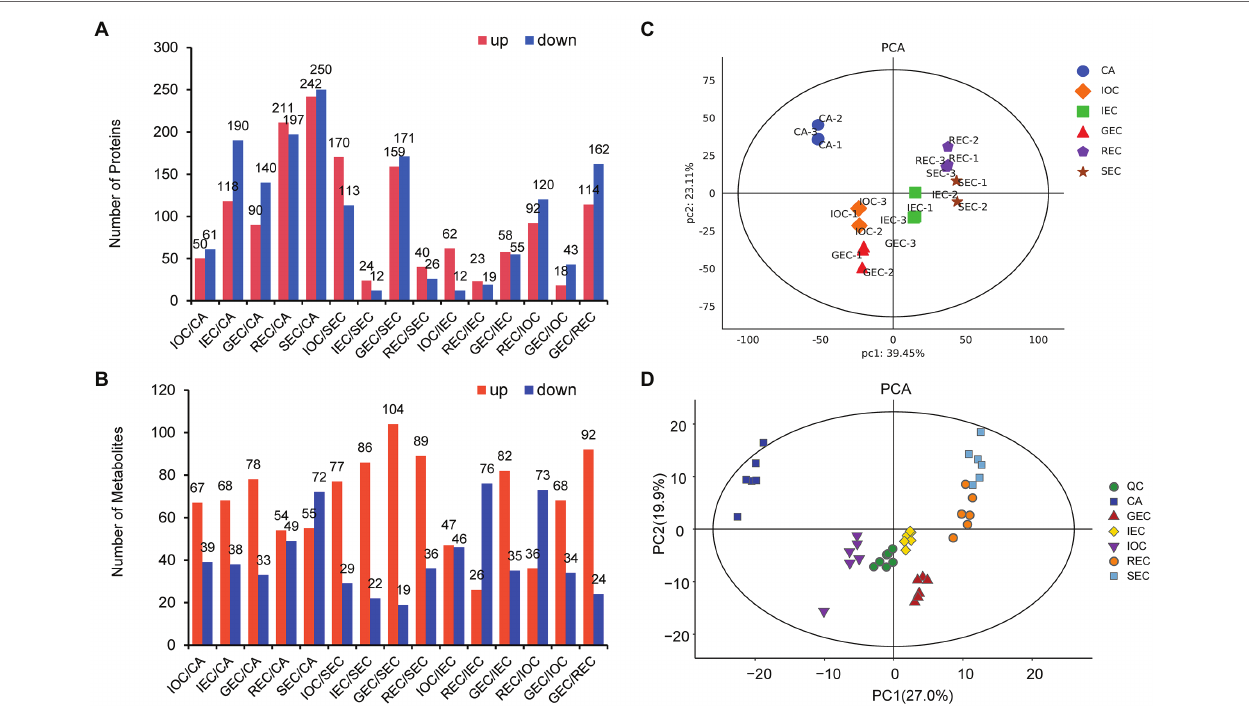
FIGURE 2 | Overview of proteomic and metabolomic differences between samples. (A) Numbers of DAPs in different comparisons. (B) Numbers of DAMs in different comparisons. (C) PCA model of proteomics. (D) PCA model for